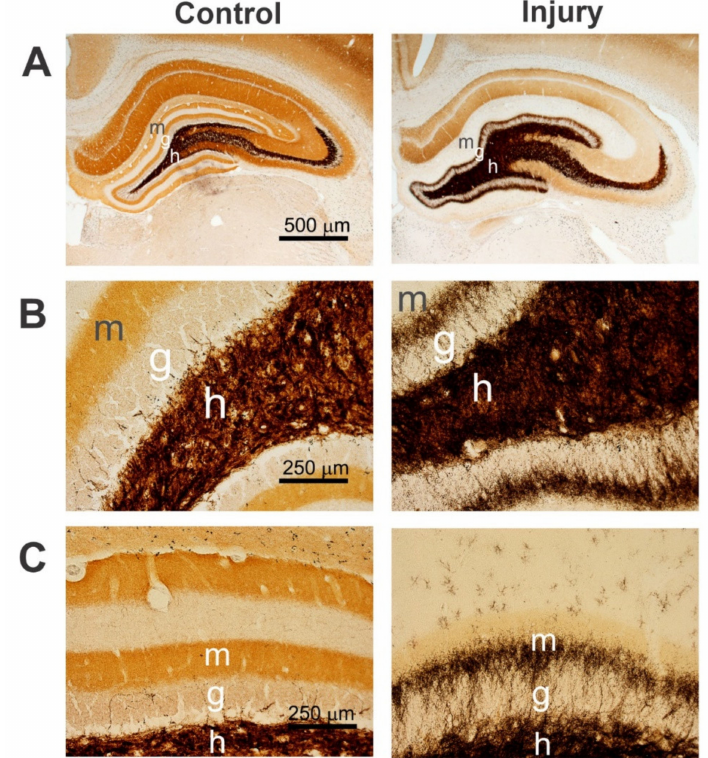
Figure 7. Timm staining of brain sections. The extent of aberrant mossy fiber sprouting in DFP- induced epileptic rats is visualized by Timm’s histochemical staining. ( A ) Representative sections of Timm (+) immunostaining of the hippocampus in control and epileptic rats, 1.25 × objective; ( B ) and ( C ) magnified views on the dentate gyrus (h = hilus, g = granule cell layer, m = molecular layer) subregion of hippocampus, 20 × objective. Images were taken via bright-field microscopy. The images were captured based on our lab’s published methodology of DFP-induced neu- ropathology (Refs.